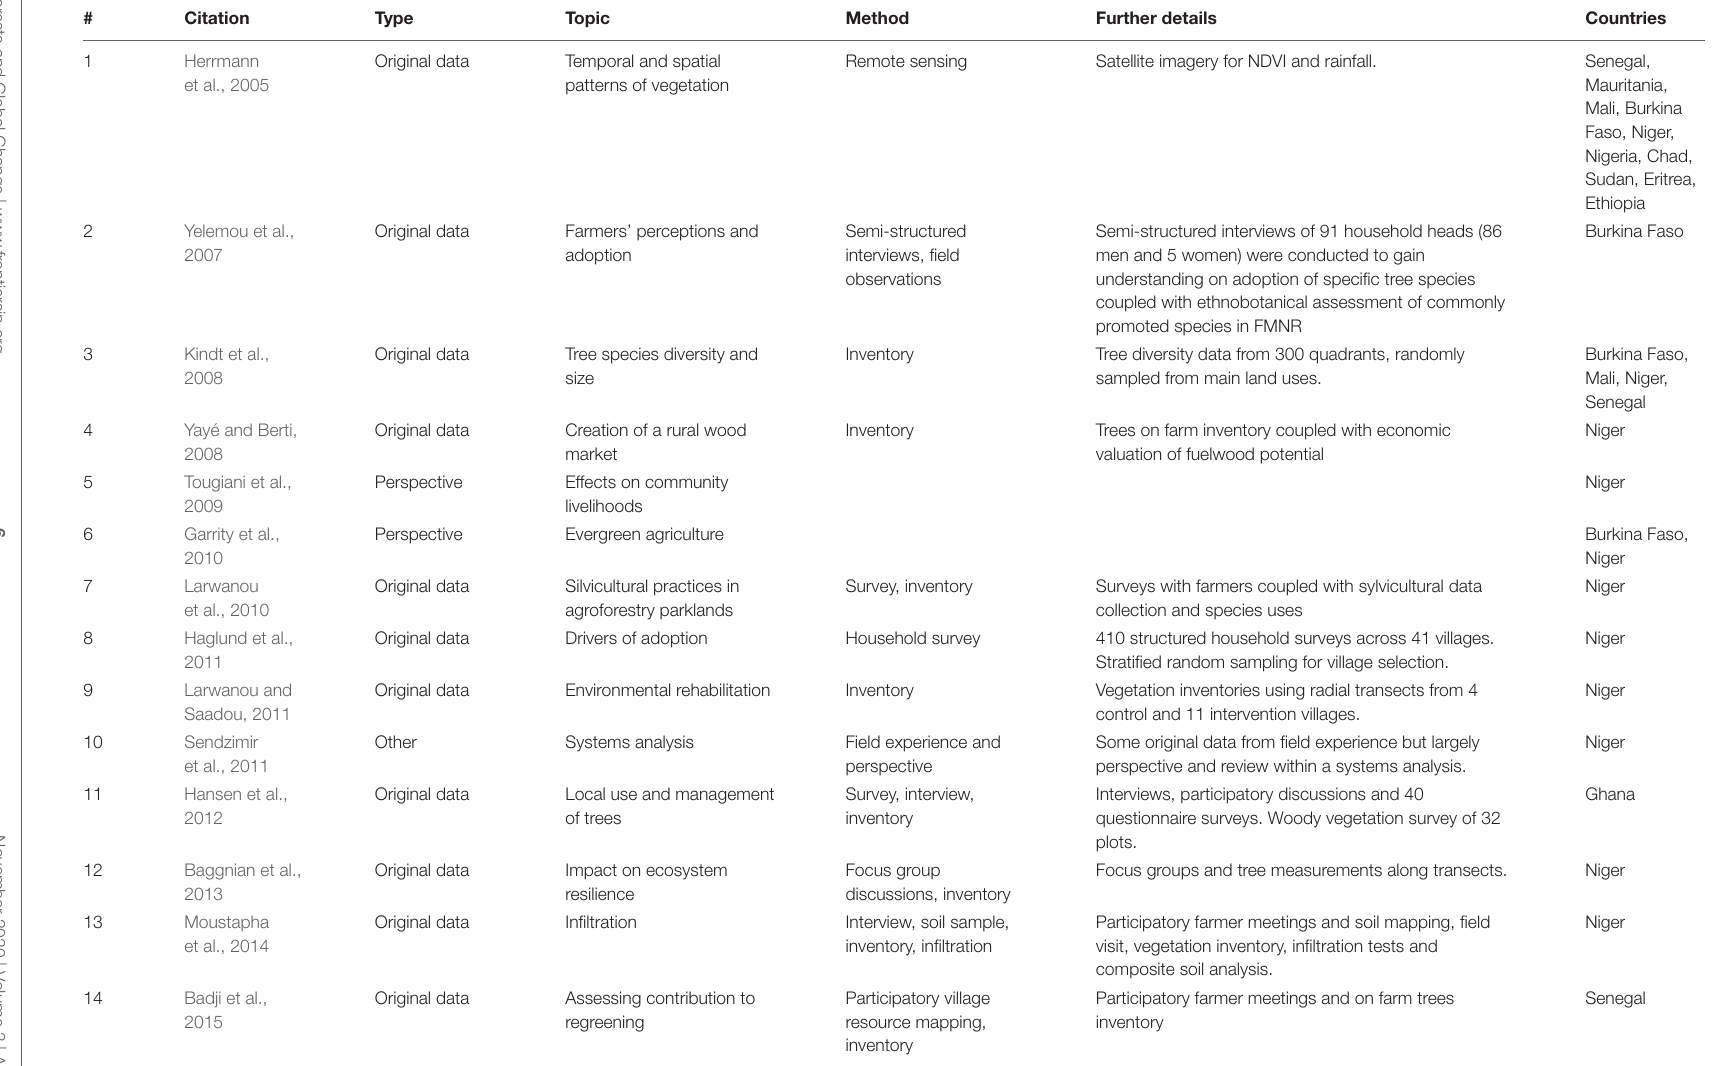
TABLE 2 | Articles about Farmer Managed Natural Regeneration (FMNR) retrieved from the literature search and used as the core evidence base for this